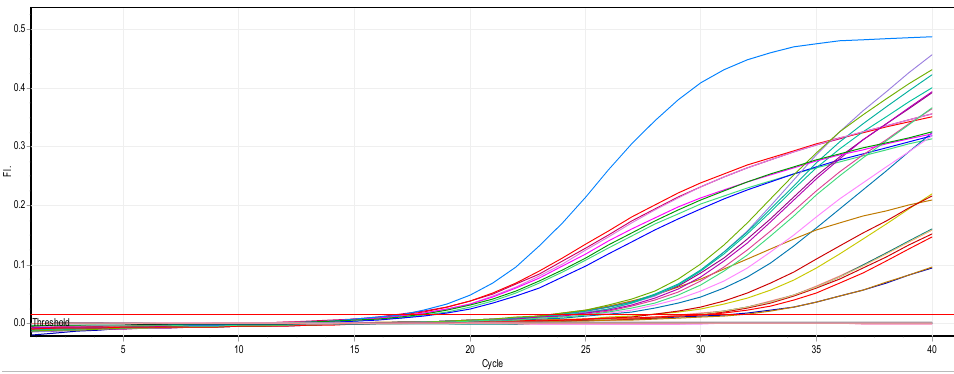
Figure 8. Real-time PCR results of the rmpA gene.